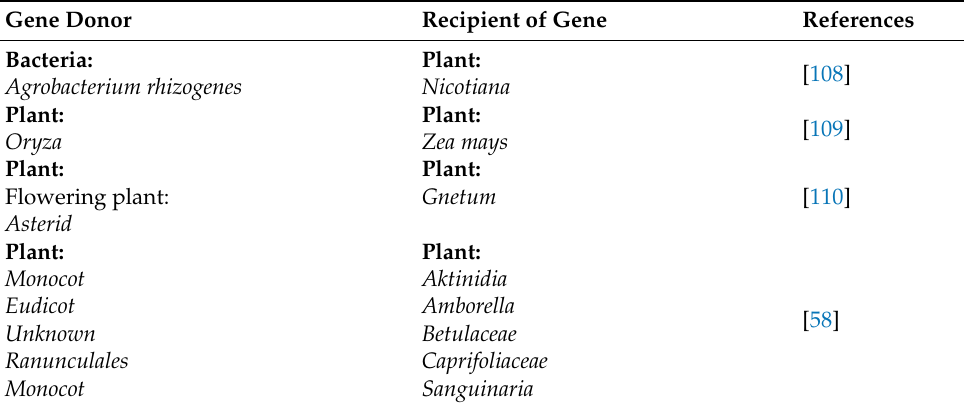
Table A1. Selected examples of organisms in which horizontal gene transfer was